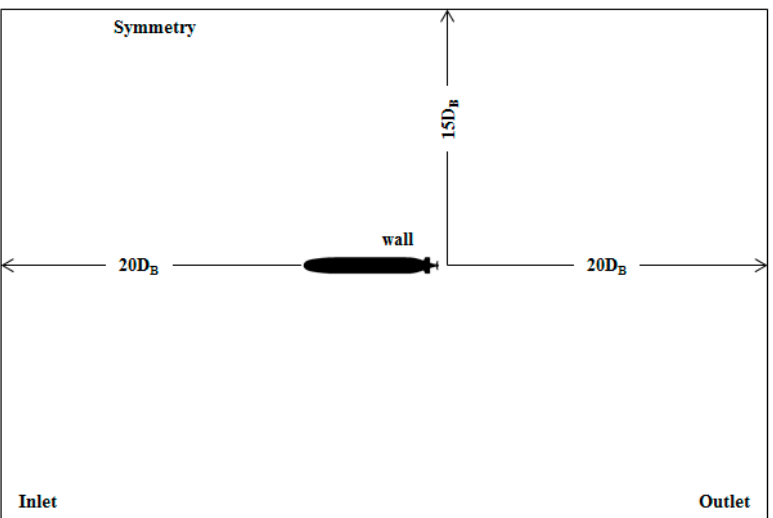
Figure 3. Numerical simulation domain.